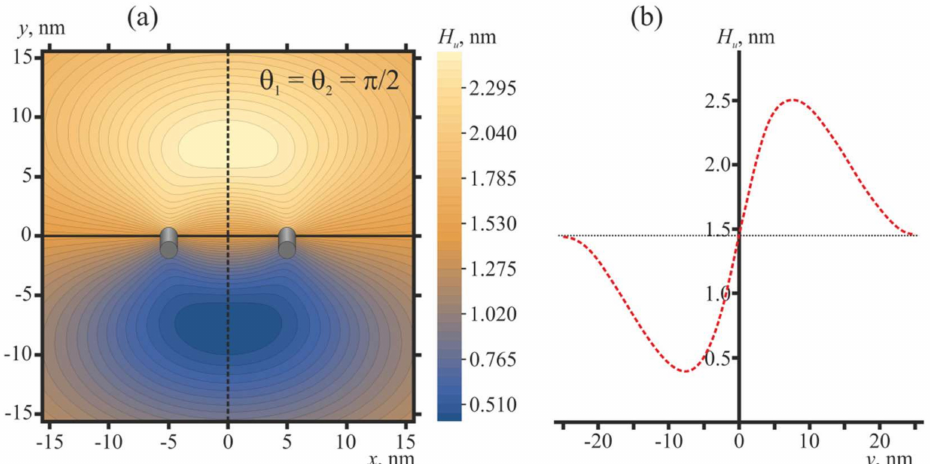
Figure 5. Membrane shape in the vicinity of two free peptide trimers in the optimal configuration ( θ 1 = θ = π / 2). The distance between the peptides is L = 10 nm, which corresponds to the conditions 2 of Figure 4b. ( a ) Contour plot of the shape of the neutral surface of the upper monolayer, H u ( x , y ). Peptides are shown as oblique gray cylinders, the centers of which have coordinates x = 5 nm, y = 0 and x = − 5 nm, y = 0. ( b ) Shape of the neutral surface of the upper monolayer, H u (0, y ), along the line x = 0 (dashed black line in panel ( a )) passing in the middle between the peptides. The horizontal dotted line corresponds to the H u value far from the